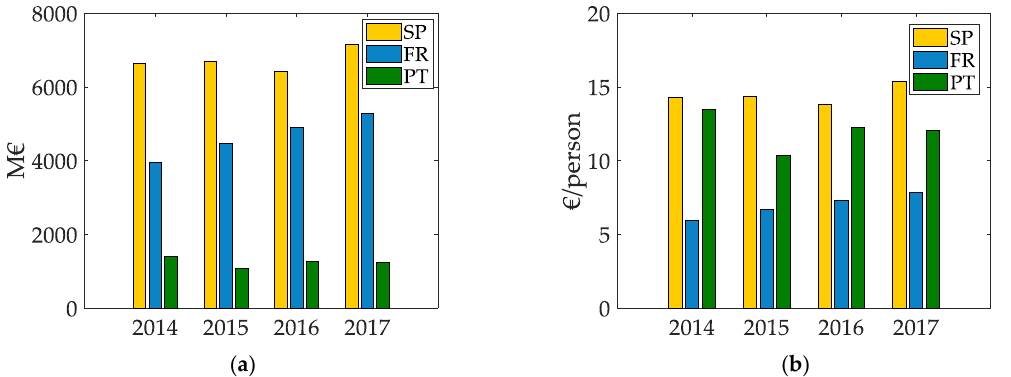
Figure 4. 2014–2017. ( a ) Annual amount of premiums to renewable-energy production for Spain (SP), France (FR), and Portugal (PT); ( b ) yearly renewable-energy premiums per capita.